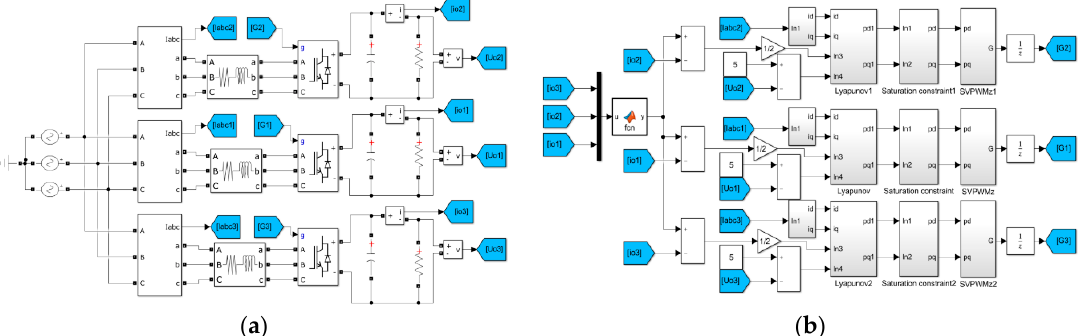
Figure 6. System diagram of the single module control of the space vector pulse width modulation method (SVPWM) rectifier.